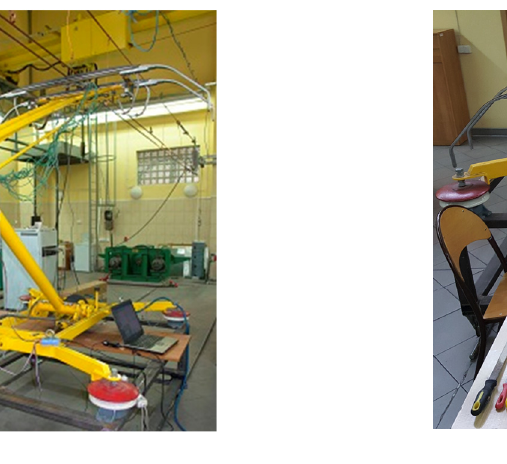
placed on the contact wire above the contact strips, as shown in Figure 2.